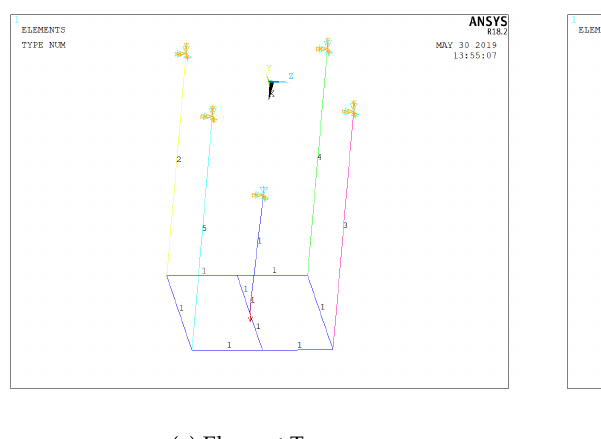
Figure 8. Class 2 tensegrity robot model in ANSYS c (cid:13)